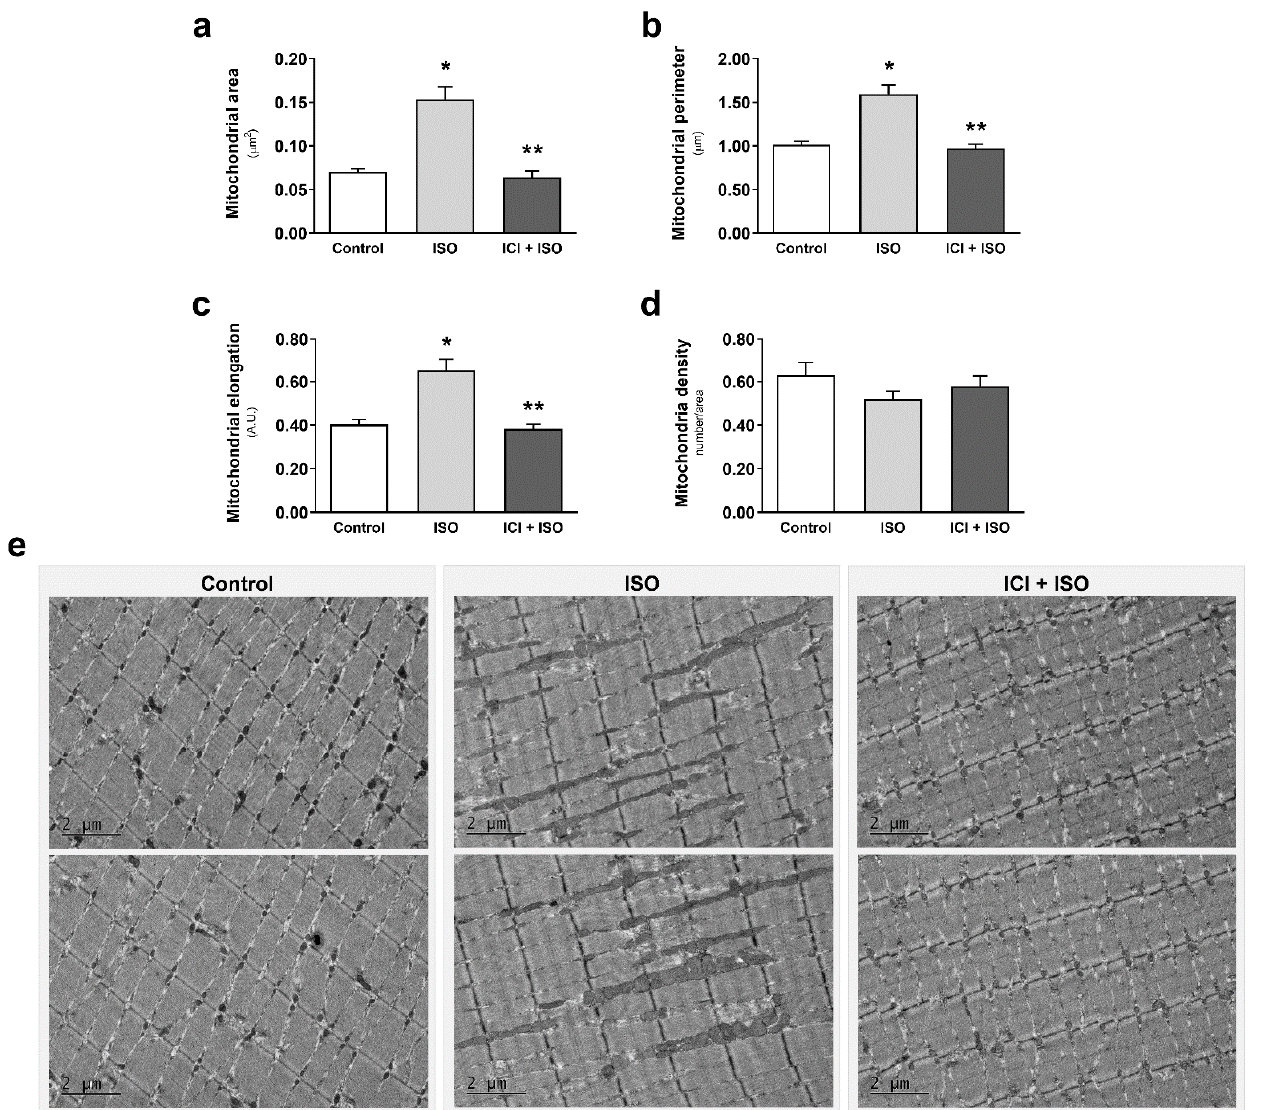
Figure 5. Pharmacological activation of β 2 -ARs leads to mitochondrial fusion in skeletal muscle. Mitochondrial area ( a ), perimeter ( b ), elongation ( c ), mitochondria number per area ( d ), and electron microscopy representative images ( e ) of tibialis anterior muscle from mice treated with the non-selective β -AR agonist isoproterenol (ISO—single dose—10 mg/kg, i.p. 30 min), with or without β 2 -AR receptor blockade with ICI 118,551 (single dose—10 mg/kg, i.p., 30 min prior to ISO treatment). Data are presented as mean ± SE. * p < 0.05 vs. control and ** p < 0.05 vs. ISO. n = 5/group.